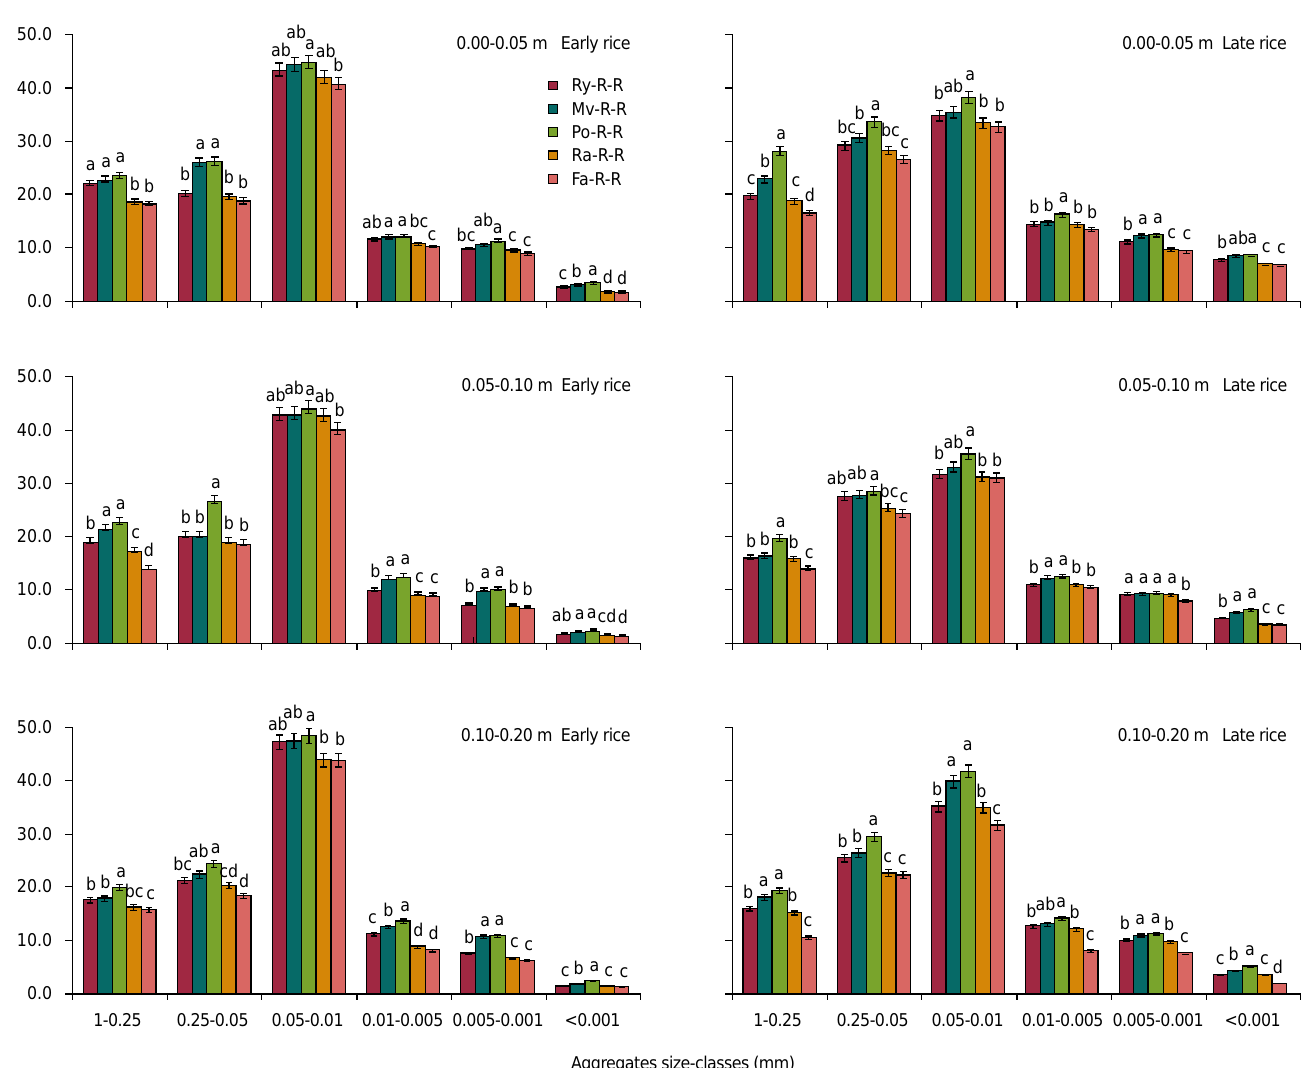
Figure 1. Aggregate size class distribution in the 0.00-0.05, 0.05-0.10, and 0.10-0.20 m layers at the early rice and later rice maturity stages. Ry-R-R: rice-rice-ryegrass cropping system; Mv-R-R: rice-rice-Chinese milk vetch cropping system; Po-R-R: rice-rice-potato cropping system; Ra-R-R: rice-rice-rape cropping system; Fa-R-R: rice-rice cropping system with winter fallow. The lowercase letters above the bars compare the five treatments within the same cropping system according to the Tukey test